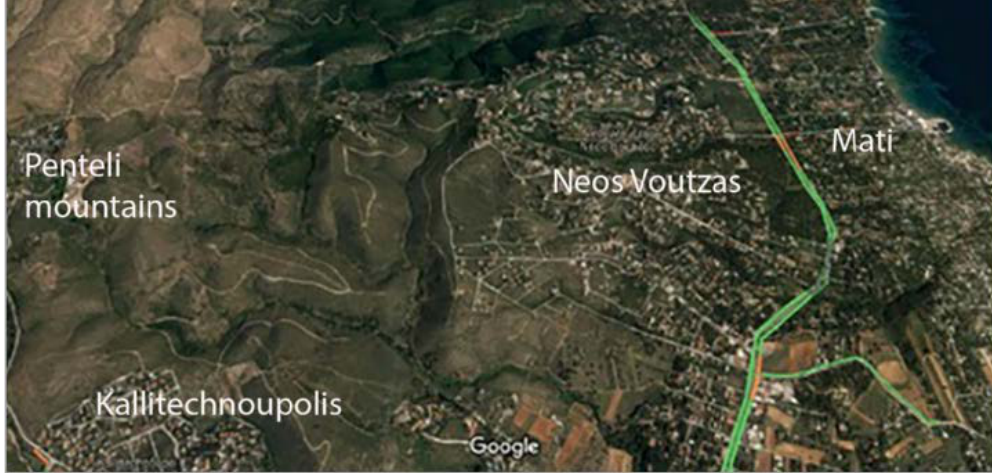
ff ected by the fire (from Google